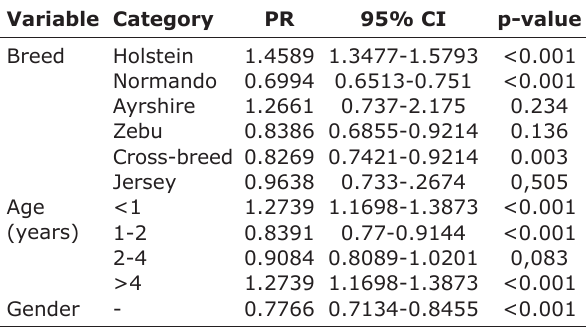
Table-3: Analysis of breed, age, and gender as a risk factor associated with BLV infection.